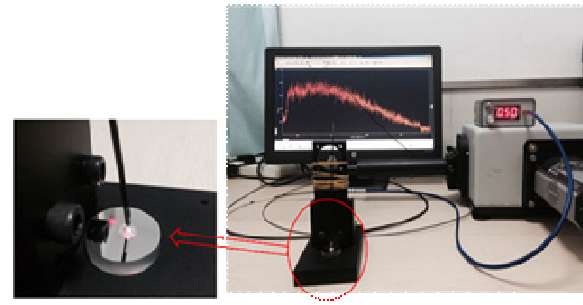
Fig. 2 Physical device diagram of the fiber-optic Raman spectrum sensing system for the fast diagnosis of esophageal cancer.